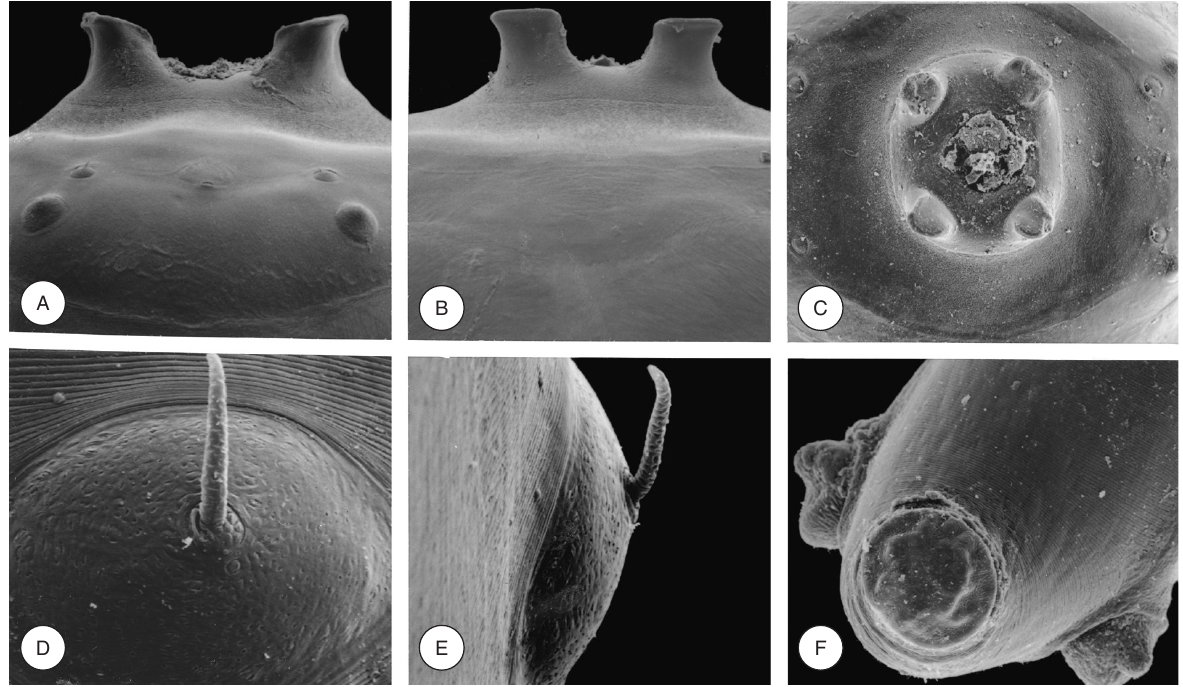
FIG. 2 Setaria hornbyi (A) Lateral view of cephalic elevations, x 600; (B) ventral view of elevations, x 600; (C) apical view of elevations, x 600; (D) apical view of deirid, x 3 000; (E) lateral view of deirid, x 3 000; (F) terminal knob of female tail, x